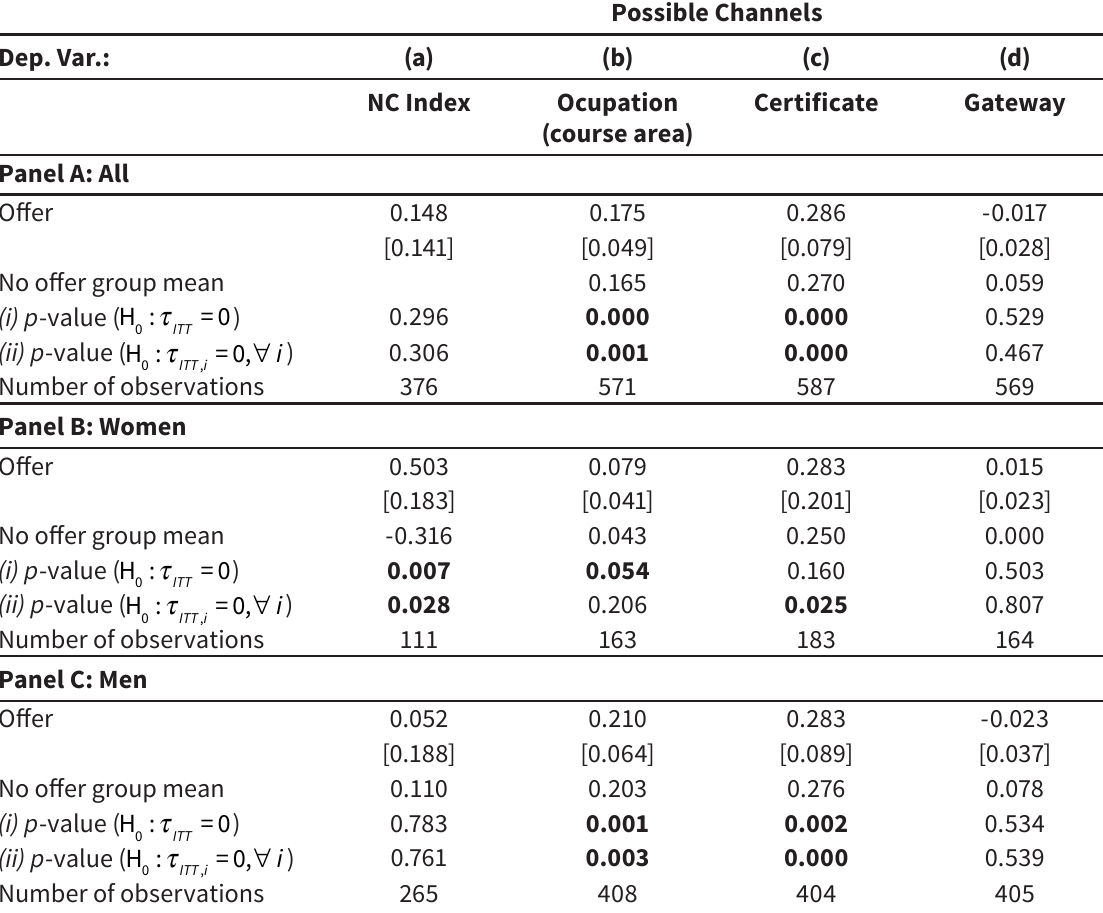
Possible Channels